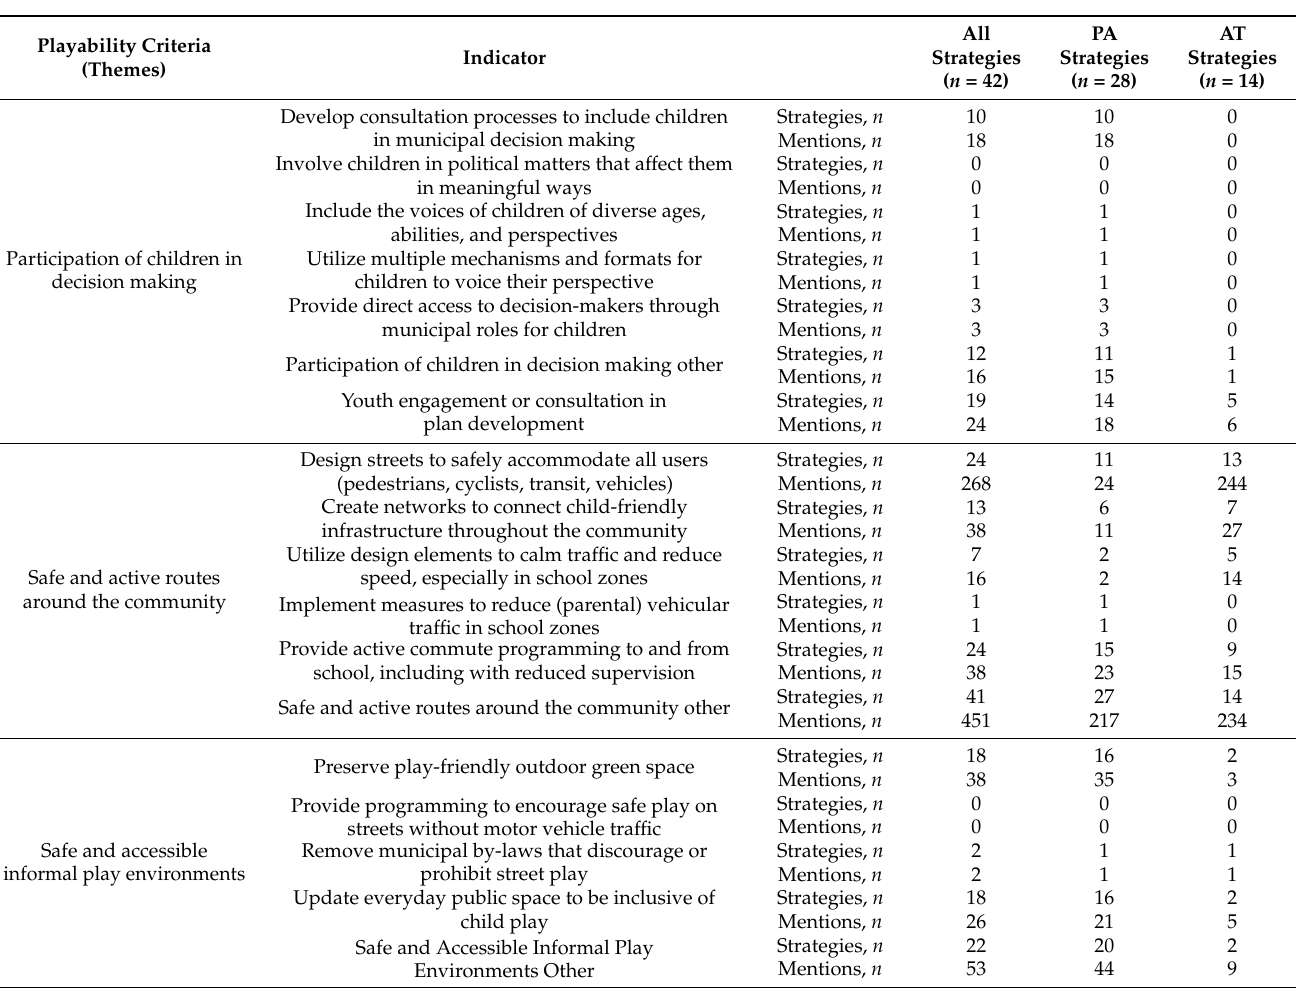
Table 3. Number of mentions and strategies that include each Play-Friendly Cities indicator in Nova Scotia physical activity and active transportation